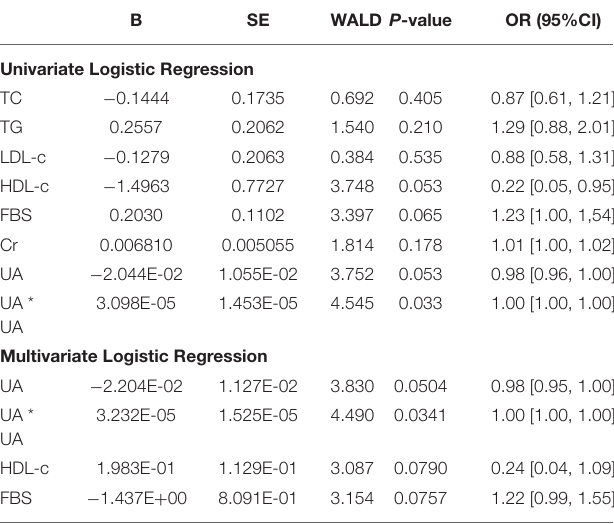
TABLE 3 | Logistic regression results.